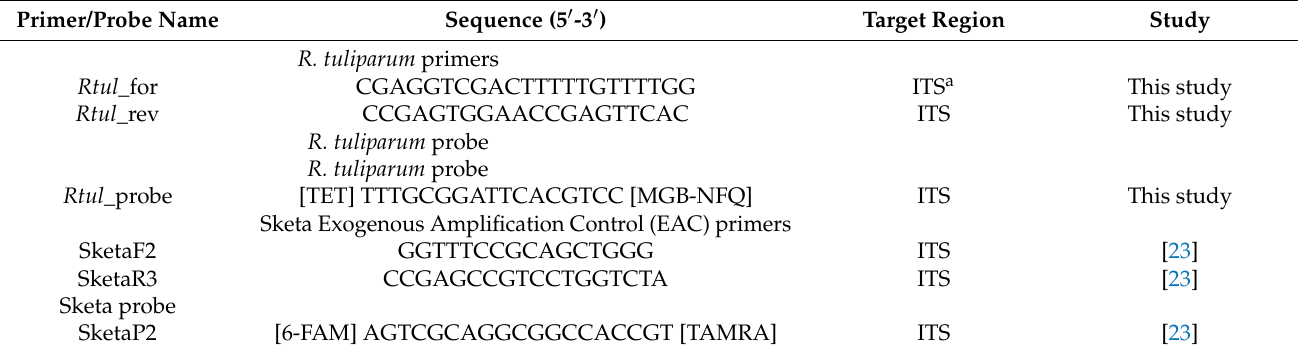
Table 2. Primers and probes used for the TaqMan ® quantitative PCR diagnostic assay for detection and quantification of Rhizoctonia tuliparum and the associated exogenous amplification control a .